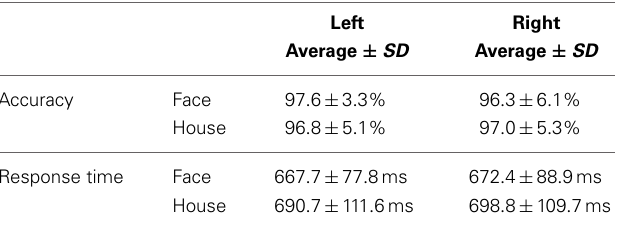
Table 1 | Accuracy and response time for button